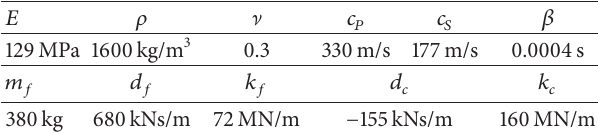
Table 4: M´evergnies site (Belgium)—half-space